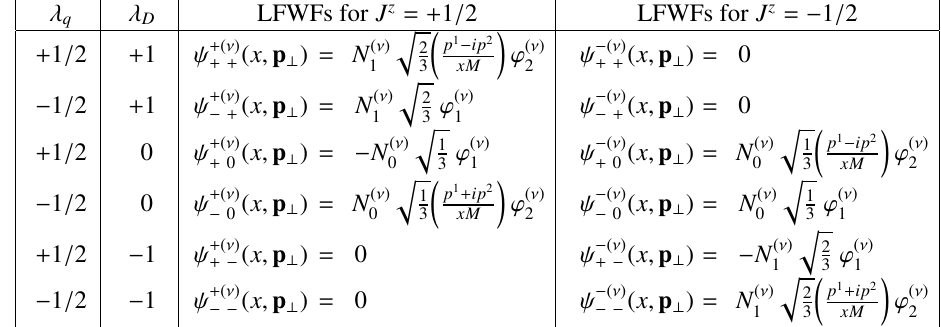
Table 2: The LFWFs for the vector diquark for the case when J z = ± 1 / 2, for di ff erent values of helicities of struck quark λ q and vector diquark λ D . N ( ν ) constants.